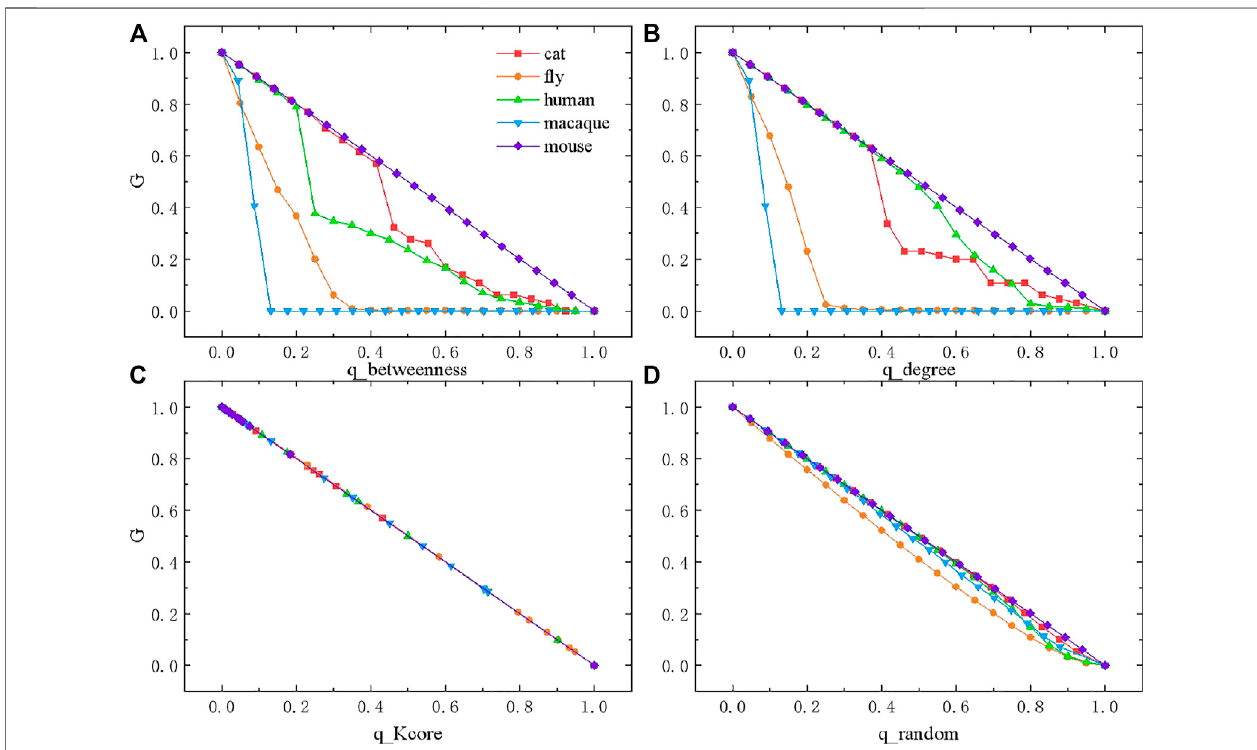
FIGURE4| Percolationonspeciesbrainnetworks underfourformsofdisturbances. (A) Percolationbasedonbetweenness. (B) Percolationbasedondegree. (C) Percolation based on k -core. (D) Random